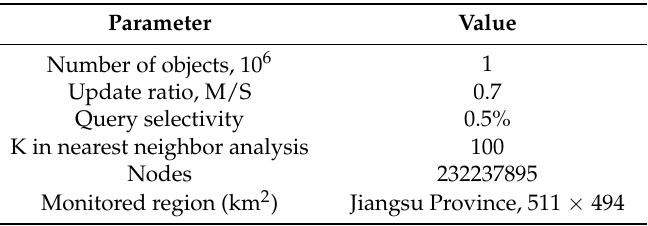
Figure 7. Moving objects in the road network. Table 2. Workload configuration for single-dataset spatial queries.